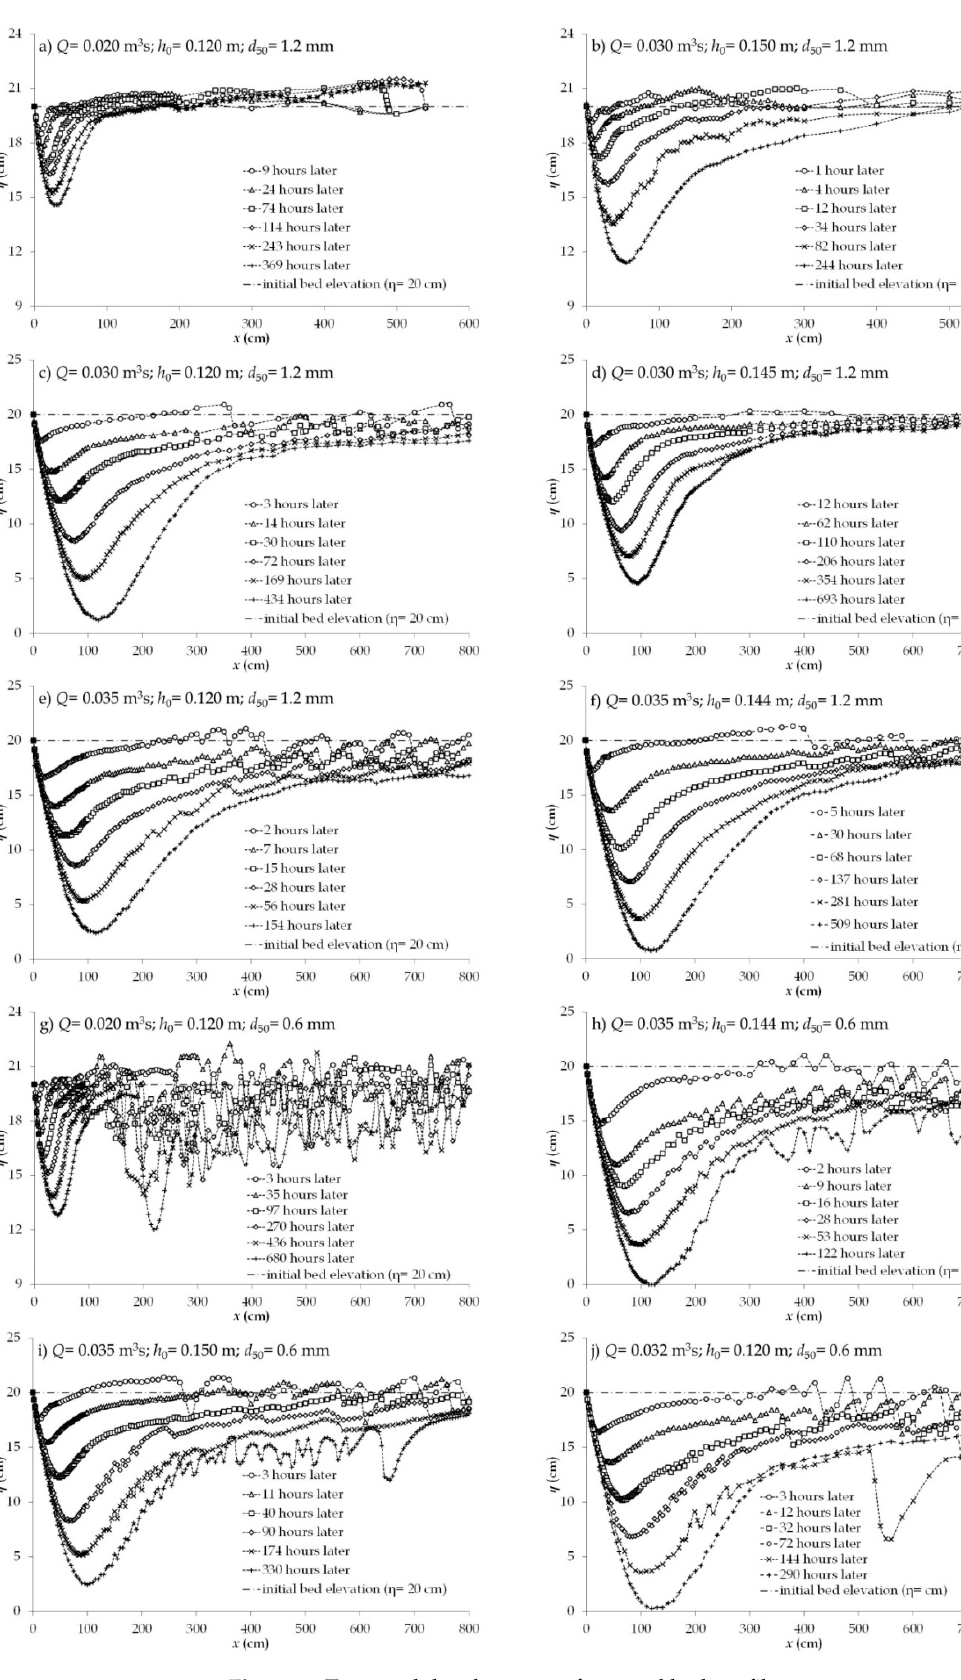
Figure 7. Temporal development of scoured bed profiles.